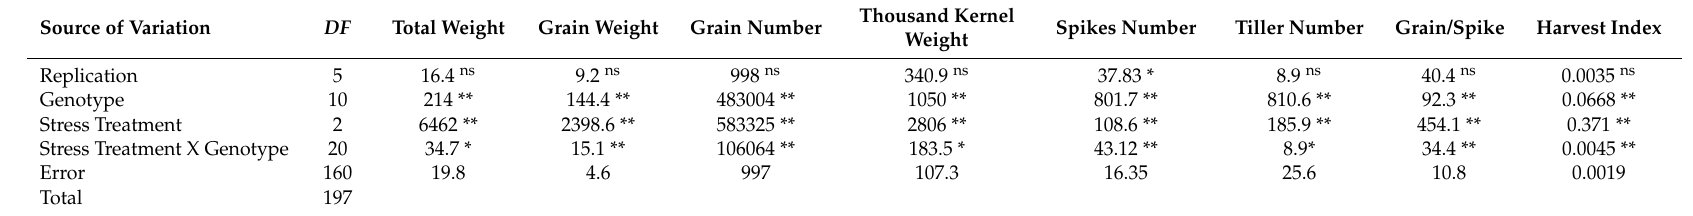
Table 3. Mean square from the combined analysis of variance of 11 barely genotypes grown under different stress conditions.